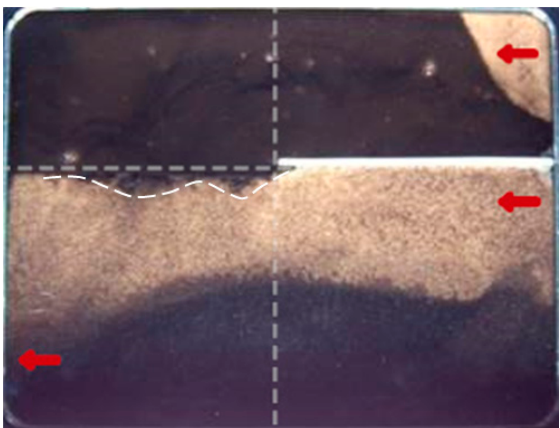
Figure 7. Distribution of miscible mass transfer between the bottom oil layer on the left side of the low-permeability layer and the CO 2 in the high-permeability layer. (The arrow at the right side is the injection end; the arrow at the left side is the production end).